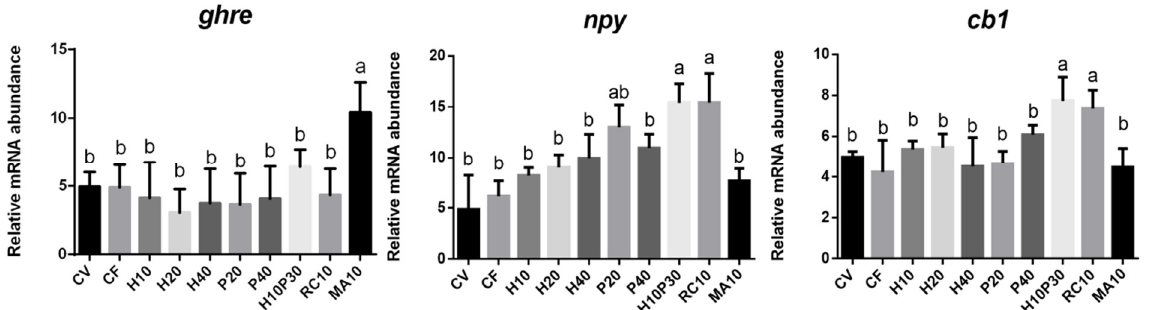
Figure 1. Gene expression of ghre in the medium intestine and npy and cb1 in the brain of fish fed different diets. a, b: different superscript letters indicate significant difference among groups ( p < 0.05).